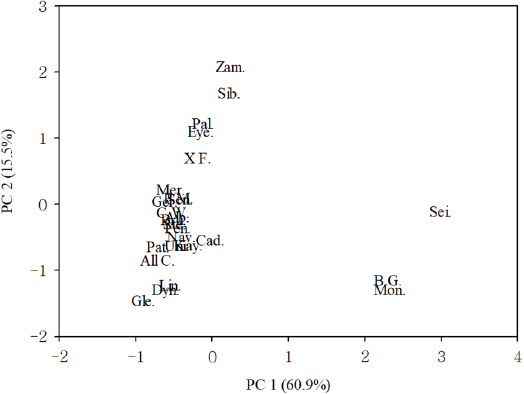
Figure 1. Distribution of lily cultivars according to multivariate factor analysis using the differences in the flower characteristic and the growth trait means, plant height, middle leaf length, middle leaf width, days to flowering, number of flowers per plant, first flower diameter, petal width, and sepal width in the control and plants subjected to NaCl treatment (8 dS m − 1 ). Albufeira, Alb.; All Choice,